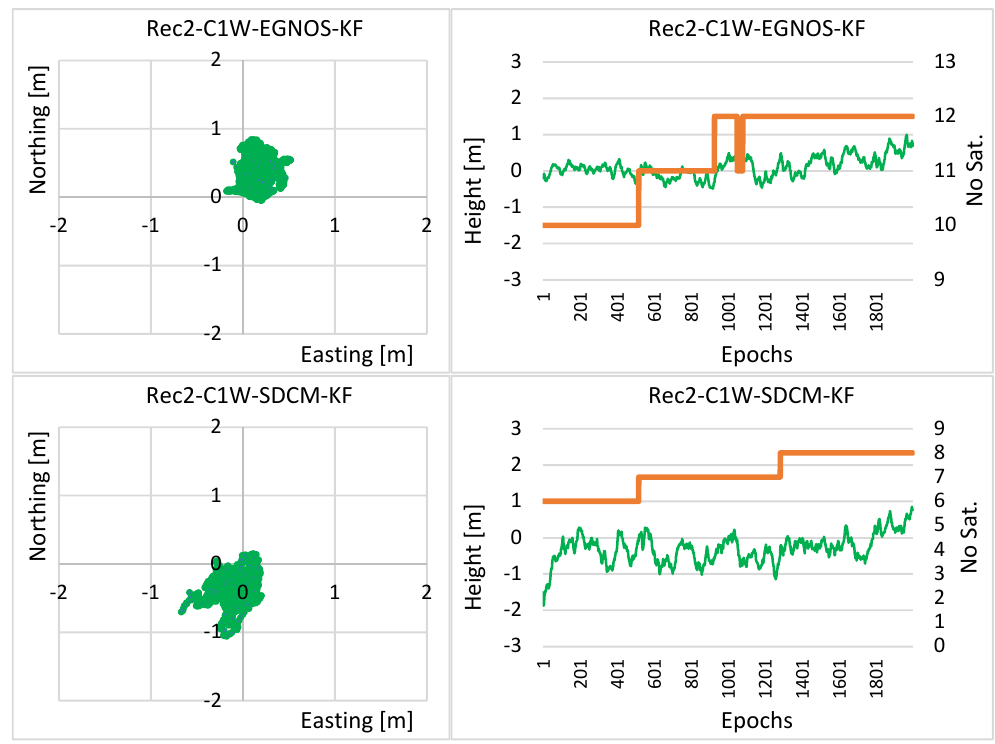
Figure 12. Real errors of horizontal and vertical coordinates of SBAS positioning based on C1W code, for the receiver Rec2 with EGNOS or SDCM corrections, with the use of Kalman filtering (Step III, see Figure 1).